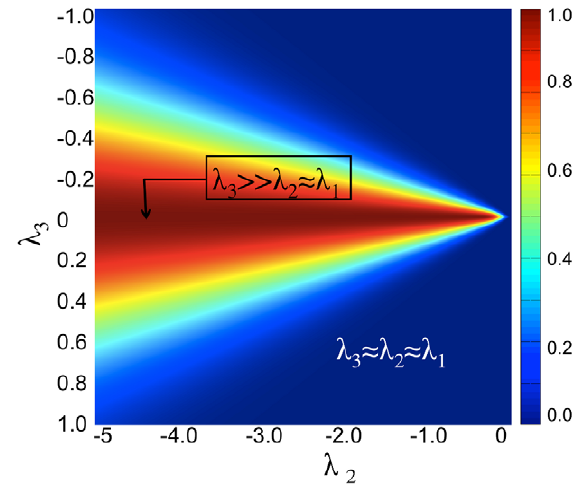
4. Smooth Plane: In order for P s to be a smooth function around the origin ( ~ ll & 0 ) and robust to noise, we add a fourth term T 3